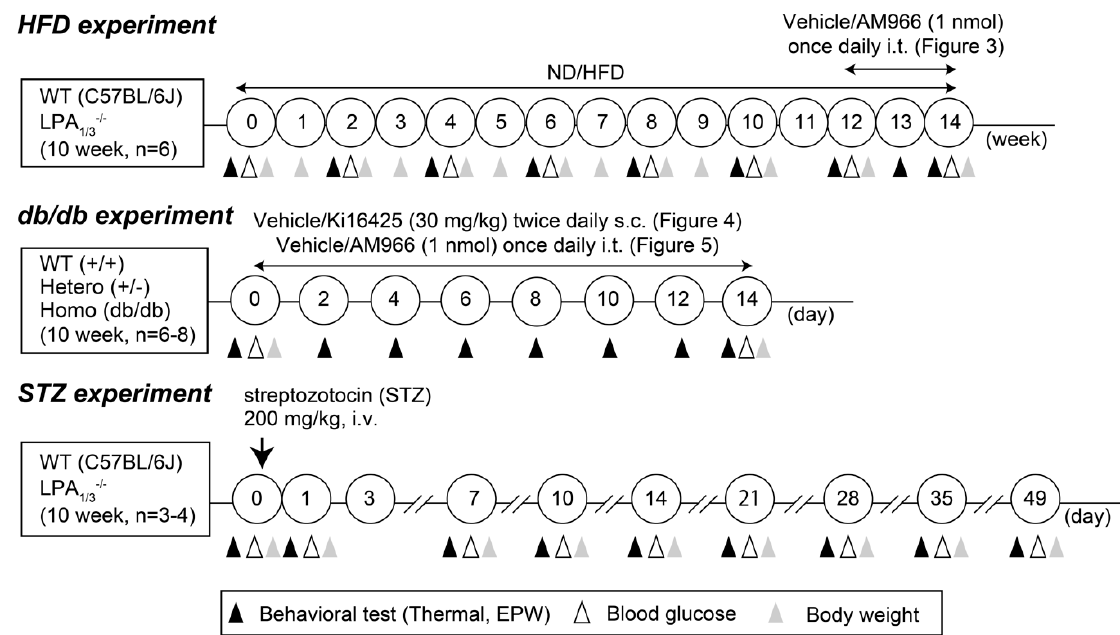
Figure 1. Schematized study of design.